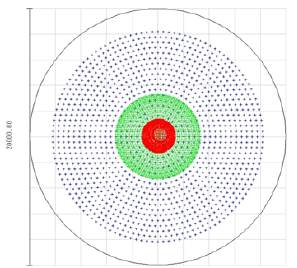
Figure 6. Field segmentation point